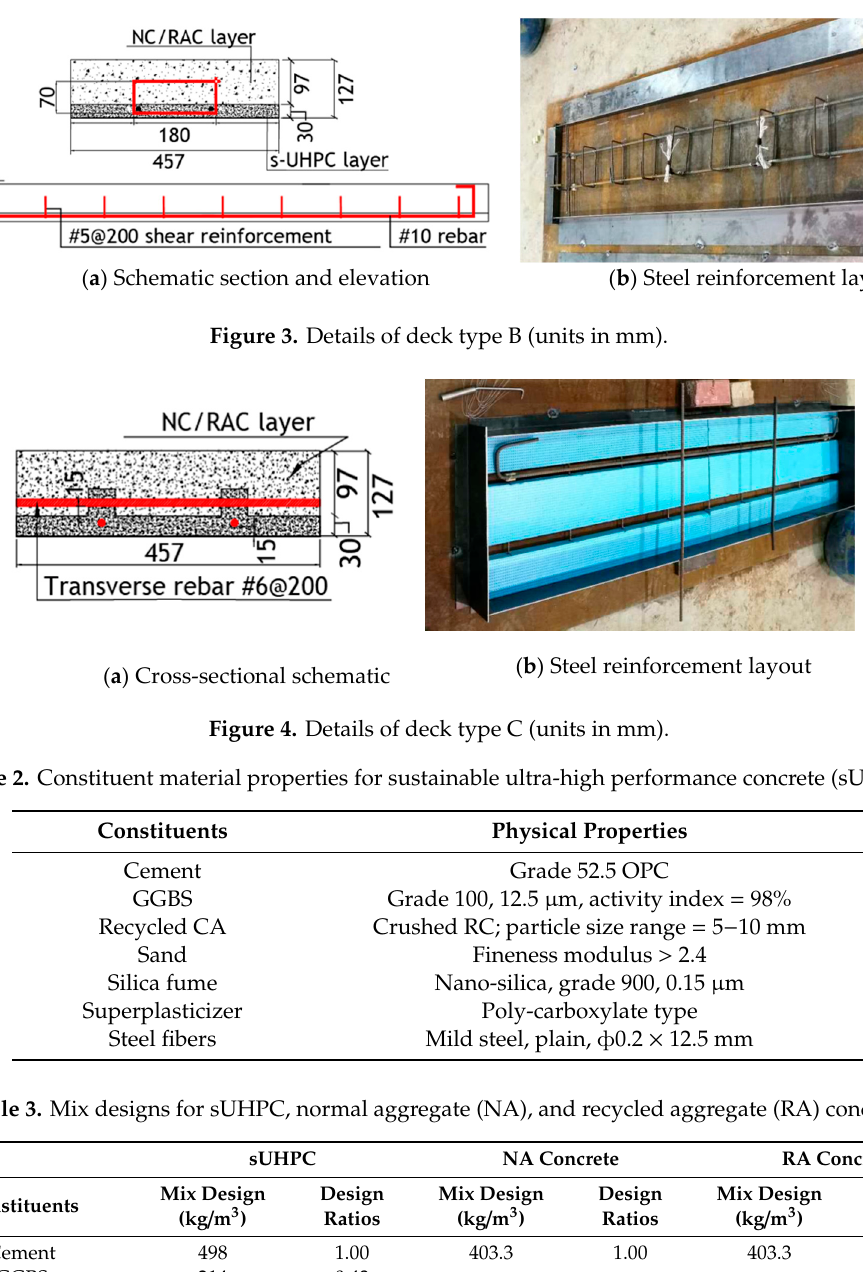
Table 3. Mix designs for sUHPC, normal aggregate (NA), and recycled aggregate (RA) concrete.